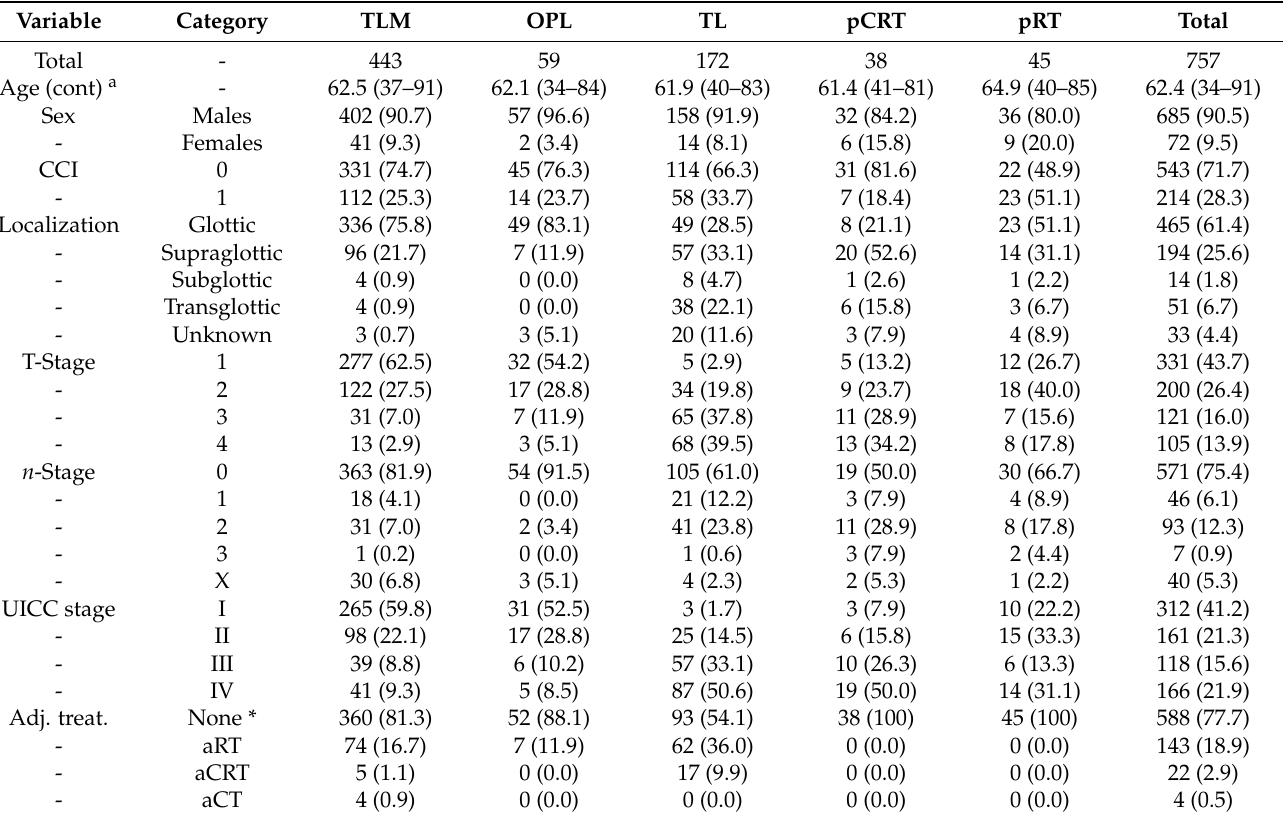
Table 1. Demographic and clinical characteristics of 757 laryngeal cancer patients.